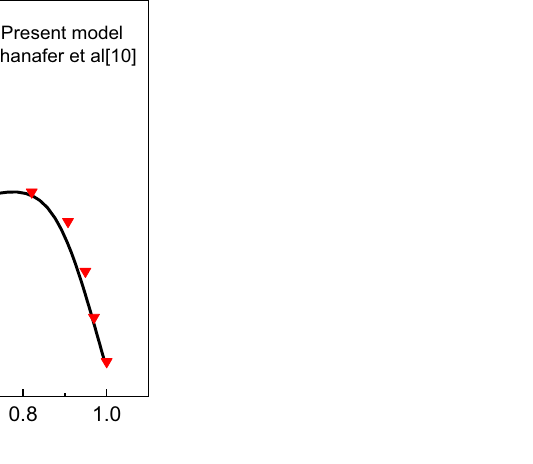
Figure 2. Dimensionless temperature distribution for (Ra = 10 5 , Pr =